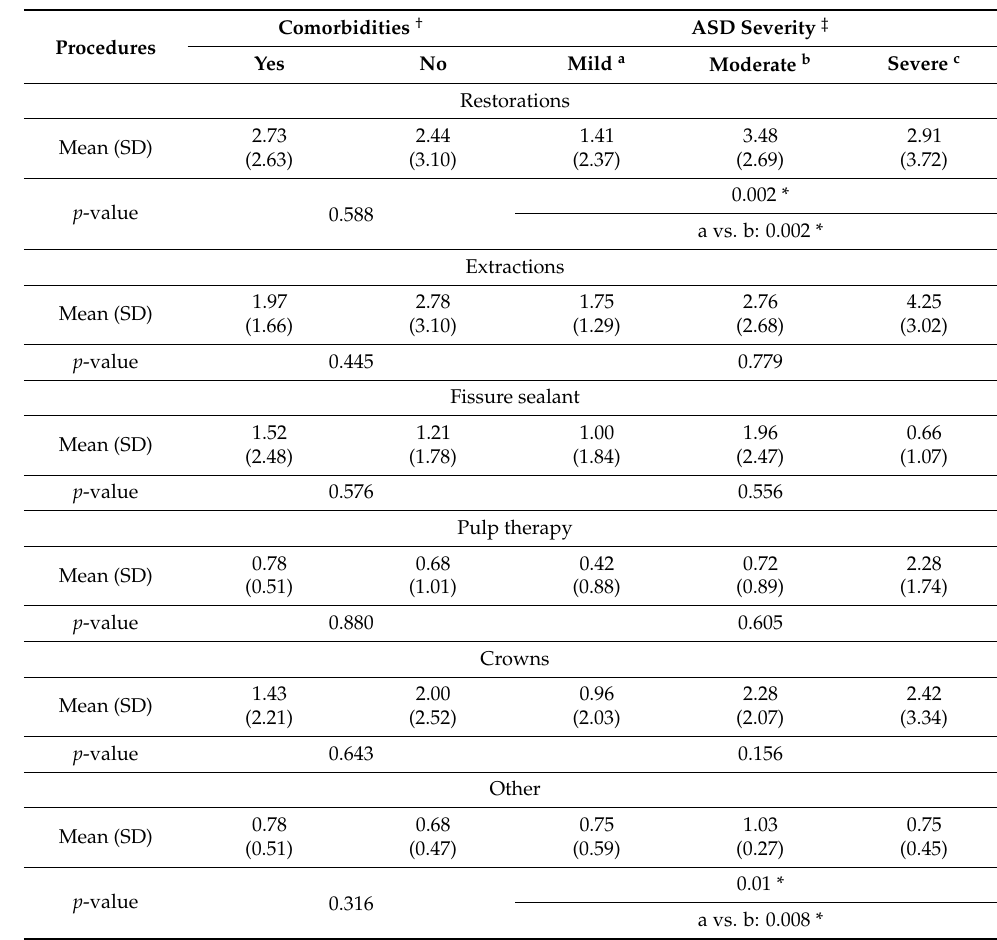
Table 5. The dental procedures provided to ASD children according to their medical